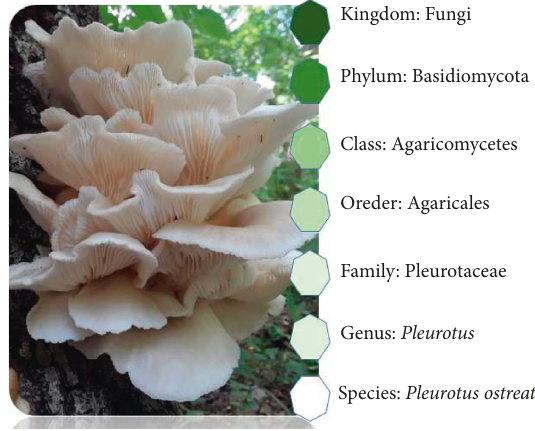
Figure 1: Taxonomic description of Pleurotus ostreatus